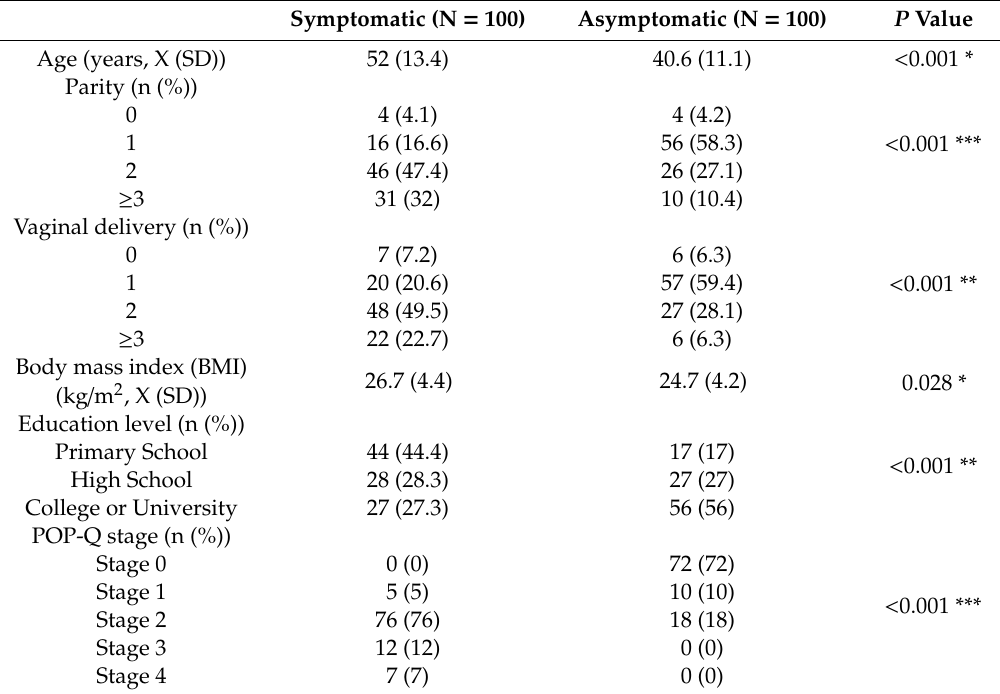
Table 1. Sociodemographic and clinical